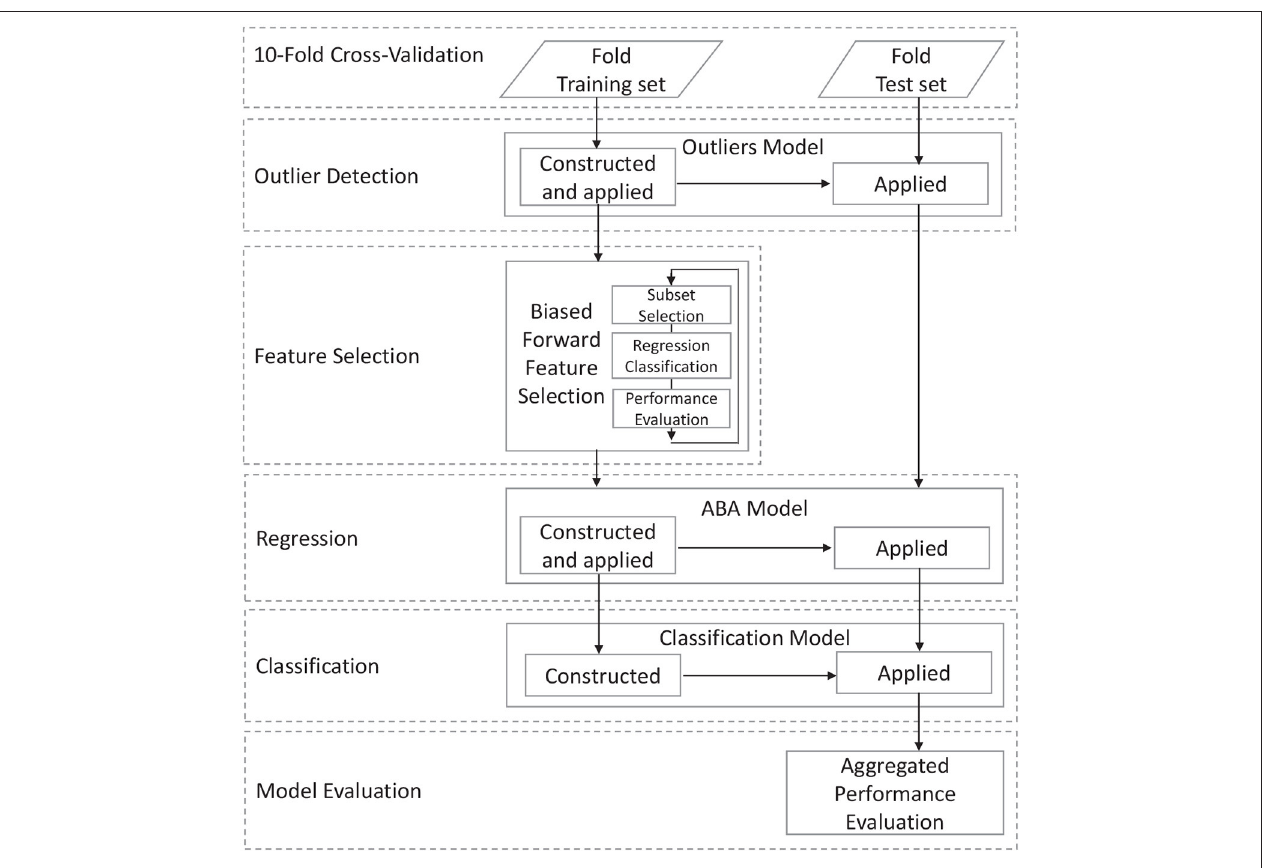
FIGURE 1 | Overall data workflow of the proposed method.